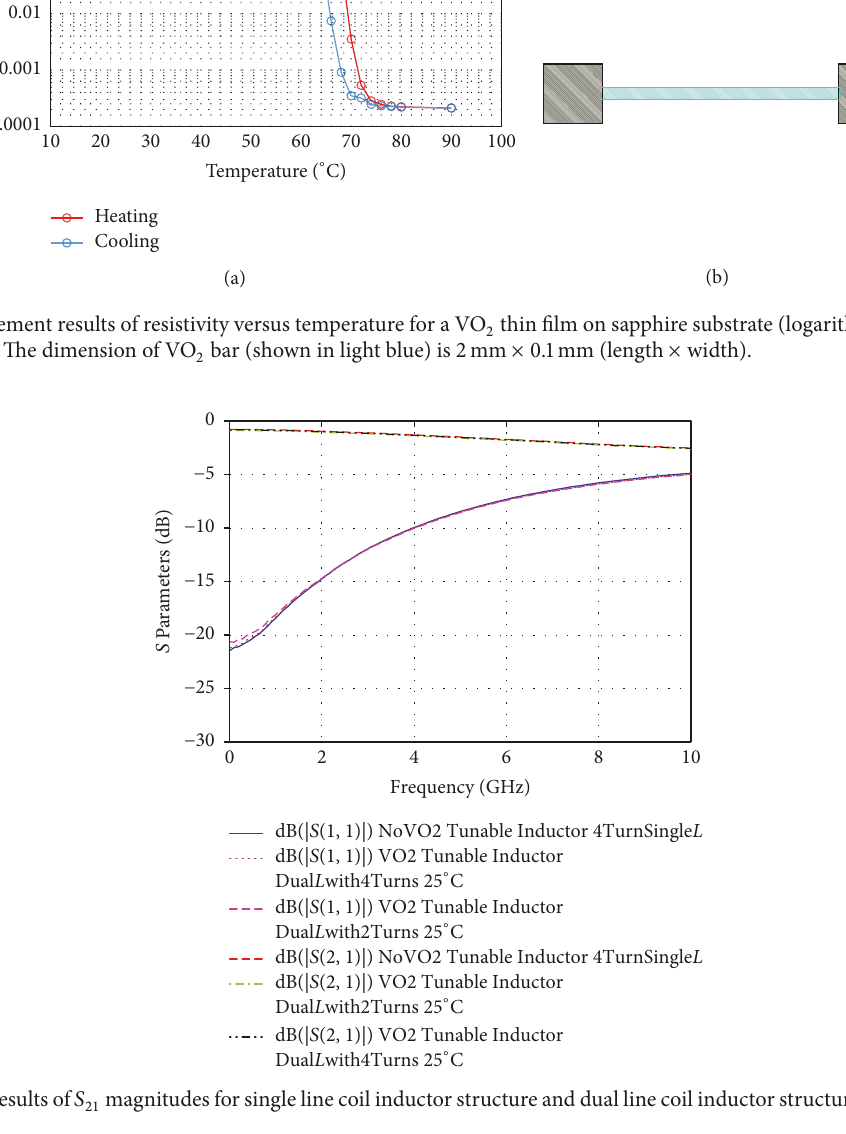
80 ∘ C. 𝑆 21 of dual line coil inductors is generally higher than 𝑆 21 of single line coil inductor dramatically, meaning that the VO 2 thin films are in the conductive state and the signal can pass through the VO 2 thin film at high temperature (80 ∘